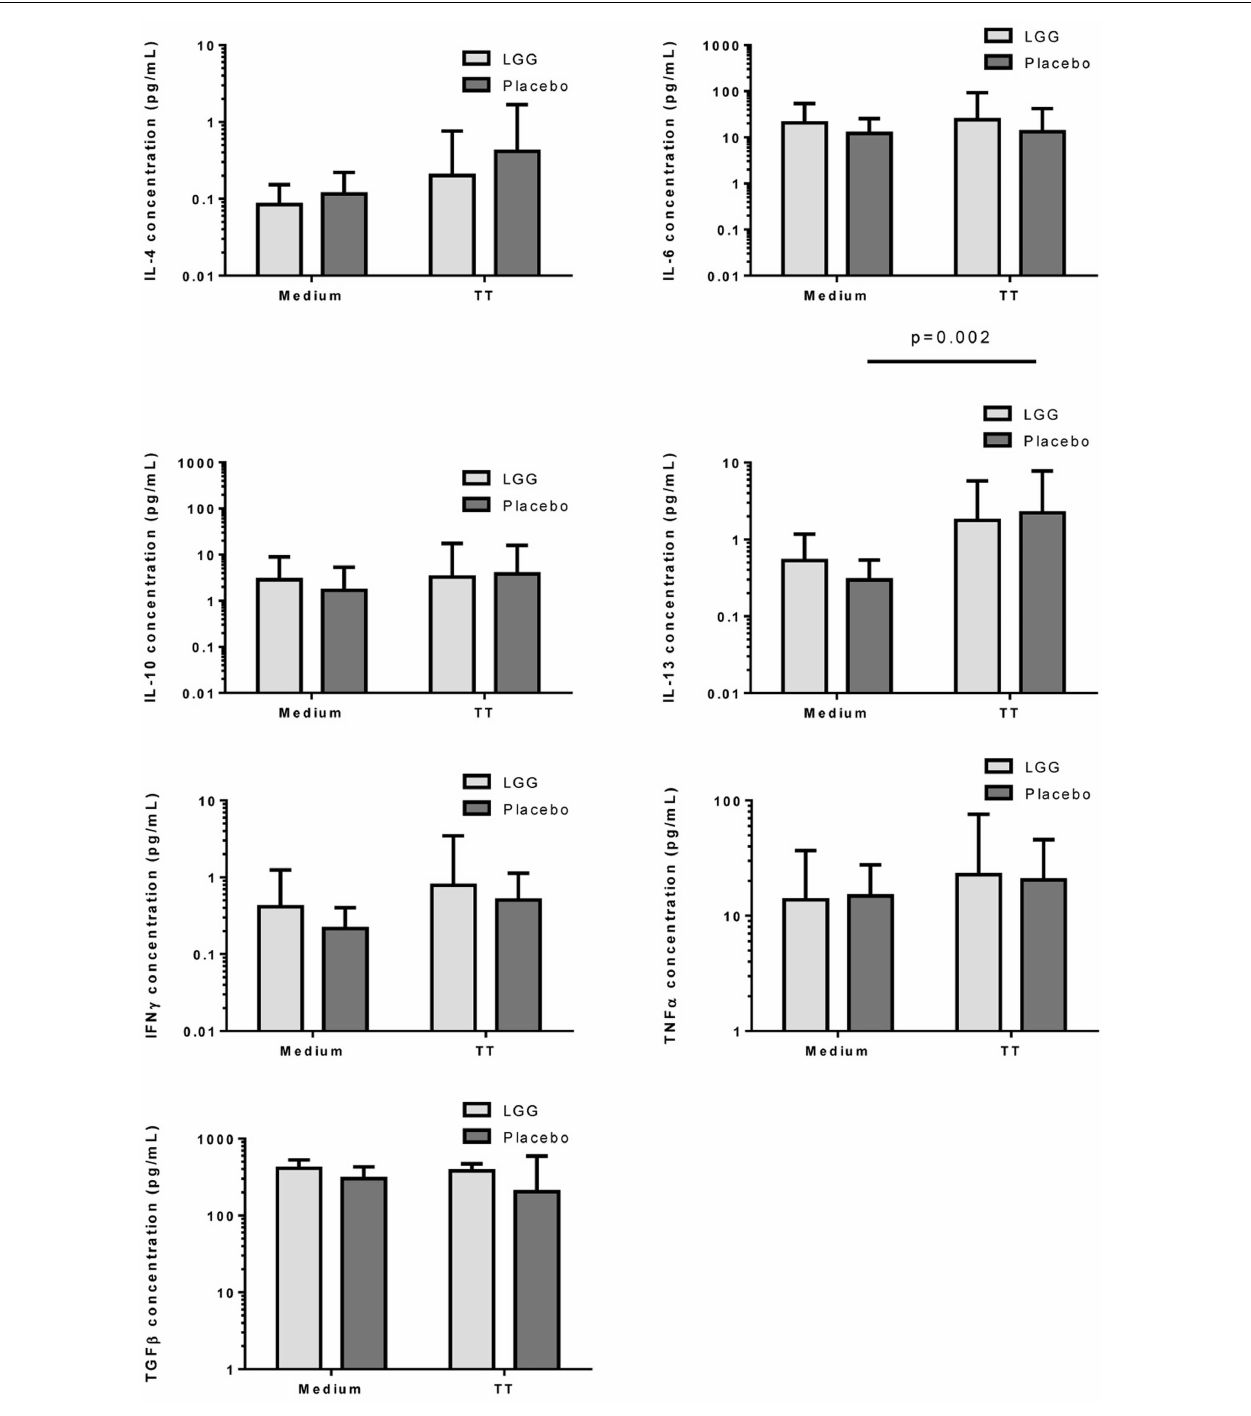
FIGURE 6 | Levels of IL-4, IL-6, IL-10, IL-13, IFN γ ,TNF α , andTGF β in PBMC supernatants following stimulation withTT (1 µ g/ml) or unstimulated (medium) for 6days at 37°C and 5% CO 2 . Bars represent GMC ± 95% CI.